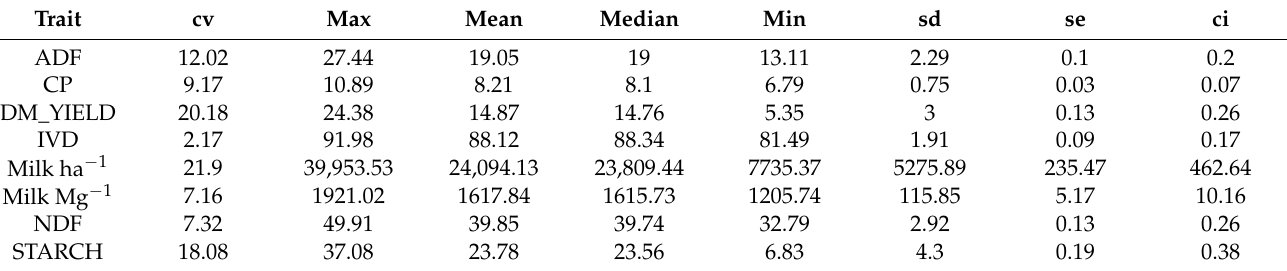
Table 2. General descriptive statistics for the